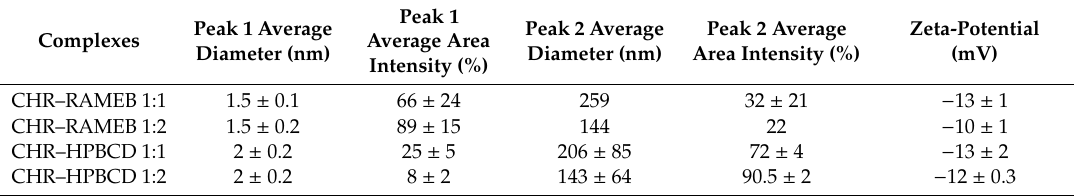
Table 1. Characteristics of chrysin–cyclodextrin complexes measured by dynamic light scattering. Peak 1 Average Complexes Diameter